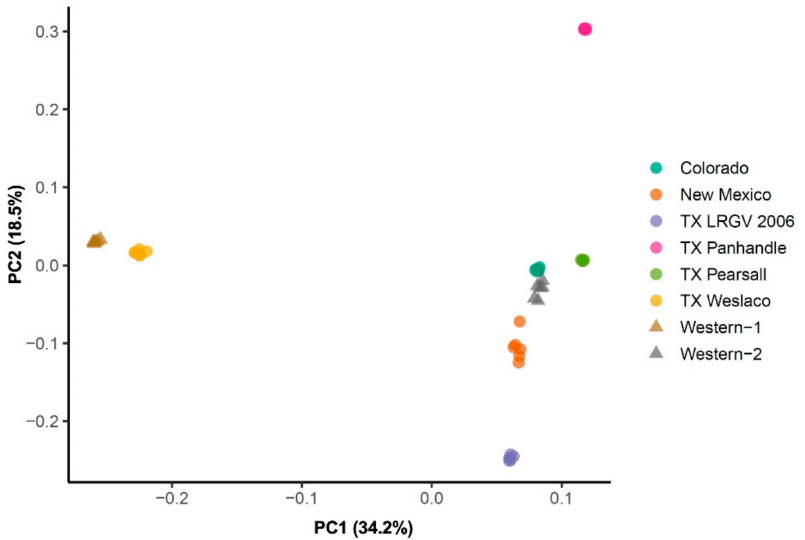
Figure 3. Principal component analysis of eight psyllid populations. PCA implemented in the PLINK using 4294 neutral SNPs marker